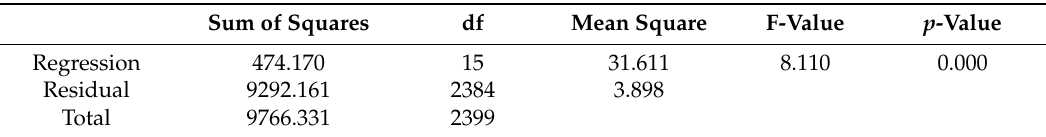
Table 5. A multiple linear regression ANOVA model describing the relationship between public perceptions and support for taxes/fees.